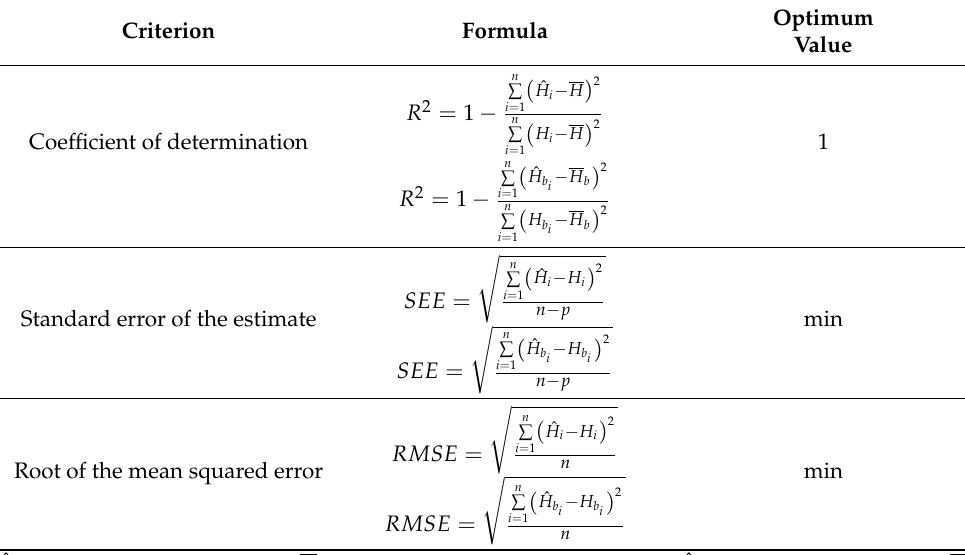
Table 3. Comparison criteria for selecting the model of best fit. Criterion Formula